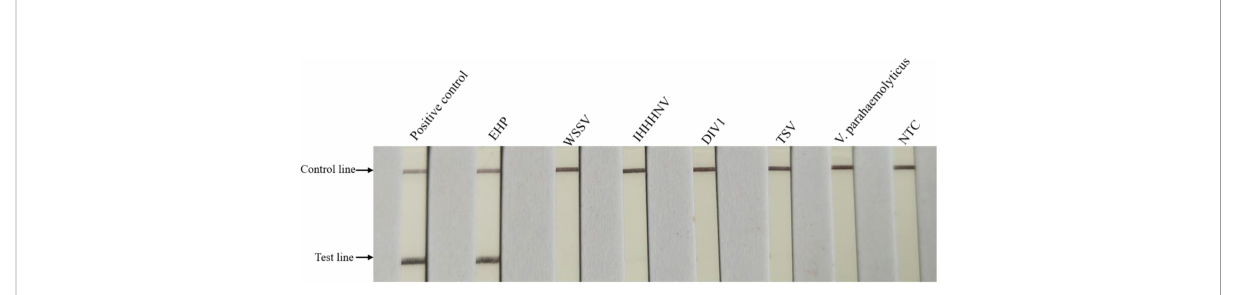
FIGURE 5 Speci fi city testing of the LFD-RPA assay. EHP and other shrimp pathogens were tested by LFD-RPA. Standard plasmid DNA (10 8 copies/ m L) and no template controls containing water (NTC) were used as positive and negative control, respectively. Only the positive control group and EHP showed bands on the test line.